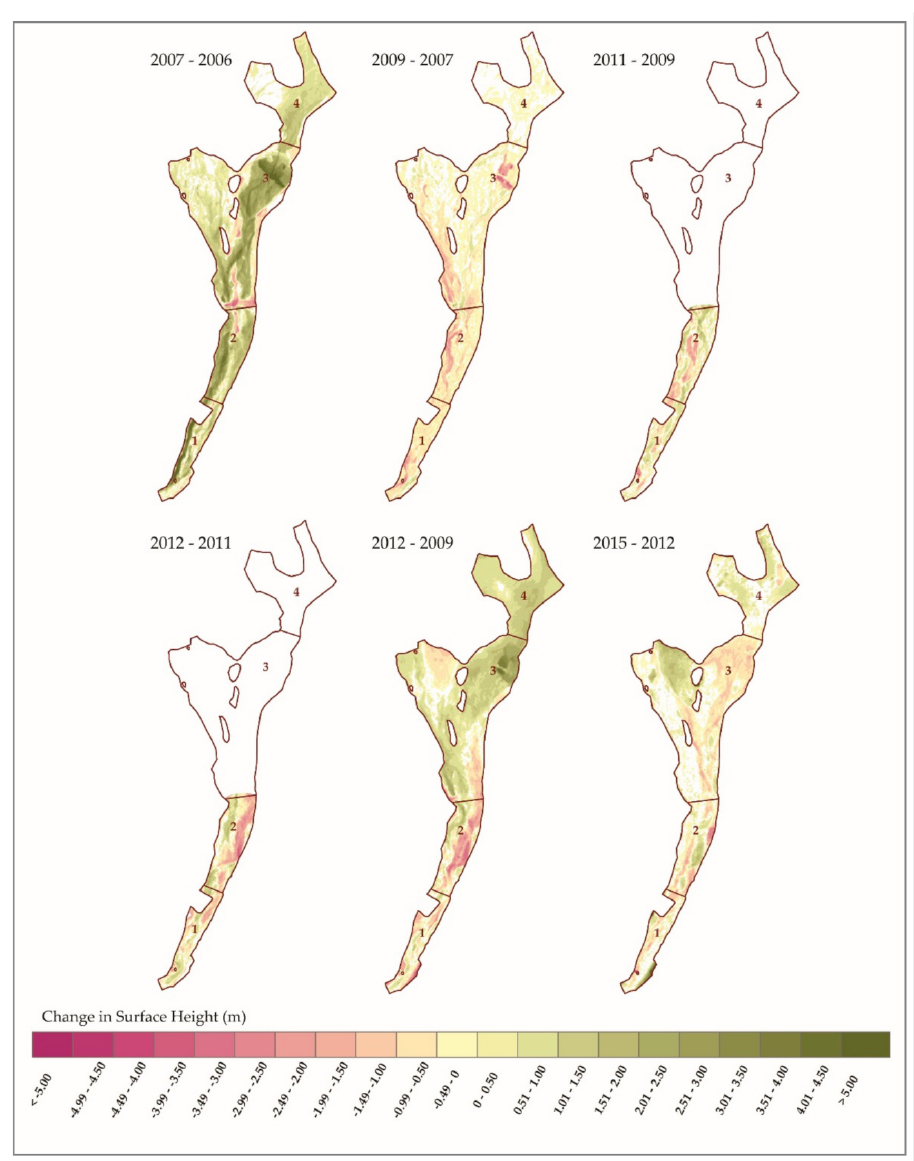
Figure 7. These DoDs were created by differencing the DEMs of successive surveys. The changes in the surface height are shown for each DEM pair, where the negative values denote the areas where erosion occurred, while positive values denote areas where deposition took place. The voids (white) are areas where the uncertainty of the measurement was higher than the calculated